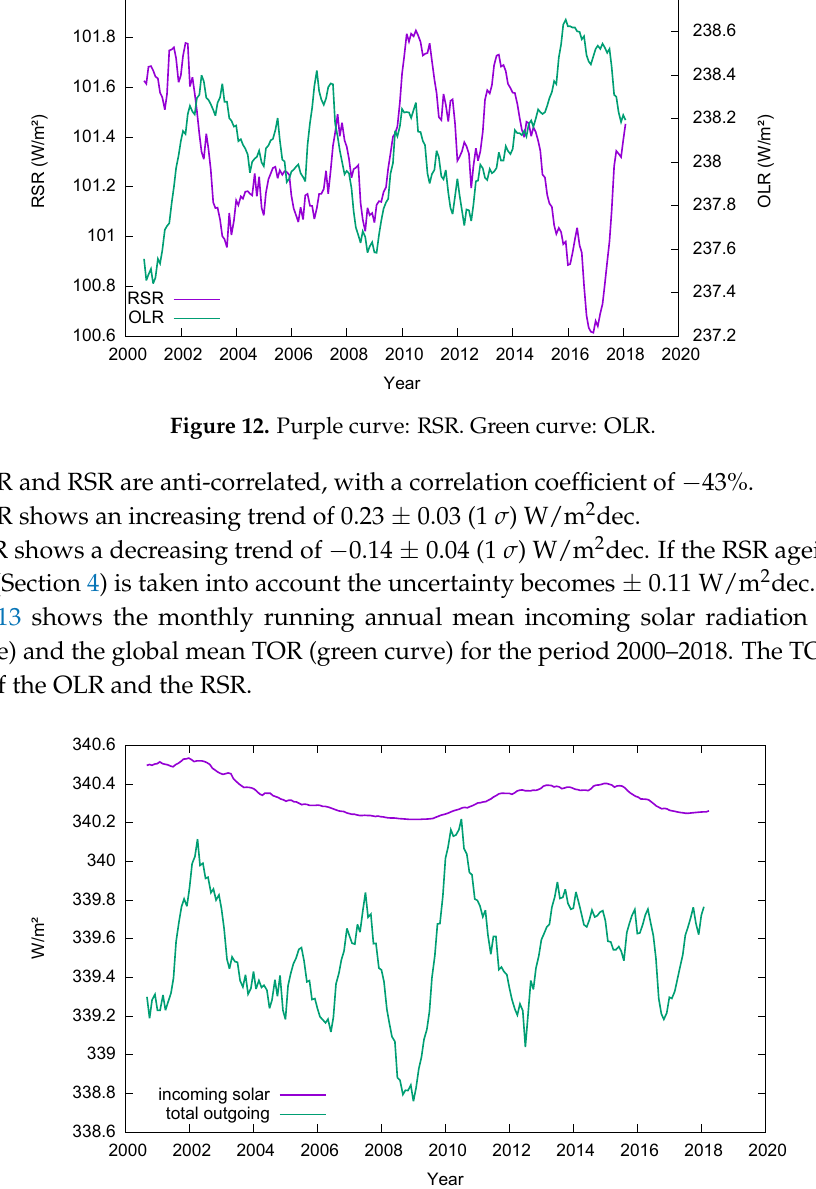
Figure 13. 2000–2018 variation in incoming solar (purple curve) and total outgoing (green curve)